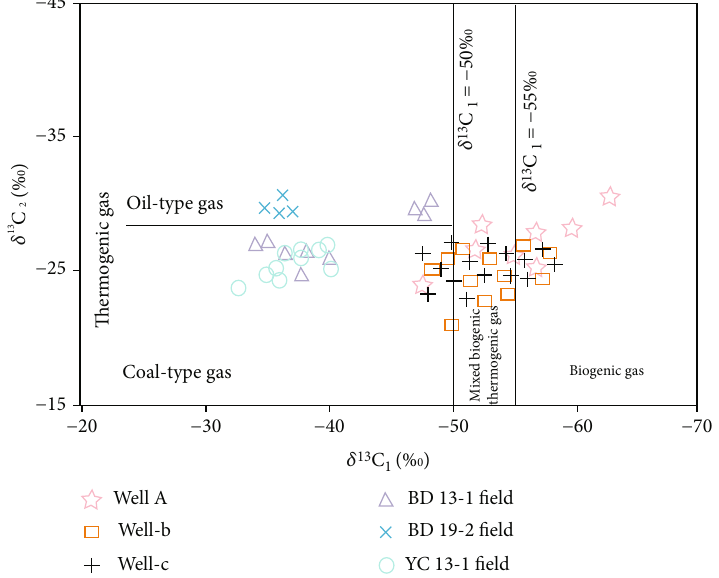
δ 13 C values of natural gas from BD13-1,